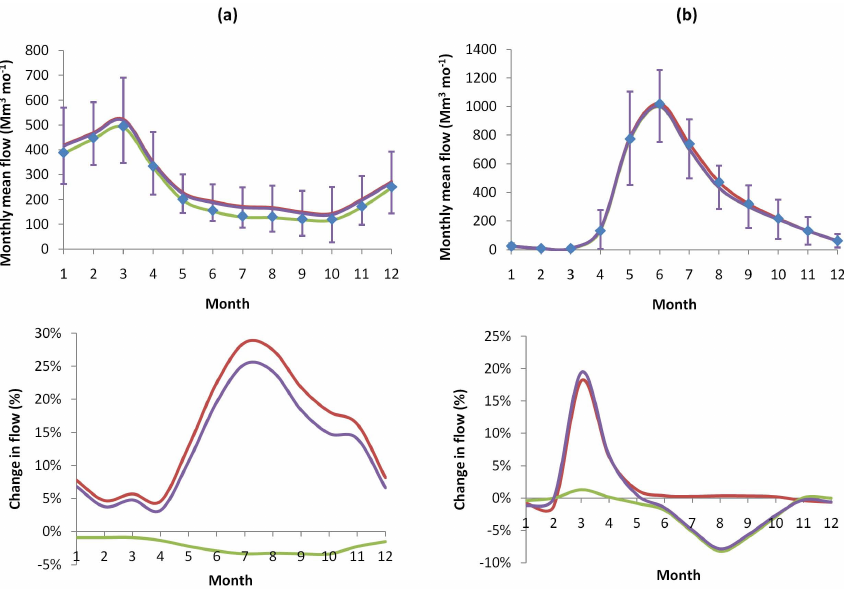
Fig. 6. Impacts of 2010 impervious cover and 2005 withdrawals on 1981-2000 monthly mean flows for HUC watershed 03130001 – Up- per Chattahoochee (Atlanta, GA area) (a) , and HUC watershed 14010001 – Colorado Headwaters (Denver, CO area by interbasin trans- fer) (b) . Error bars represent one standard deviation about the mean monthly flows when both impervious cover and withdrawal impacts were